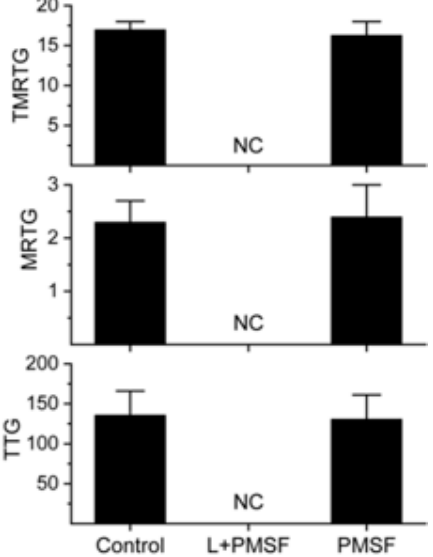
Figure 5. The effects of exposure of the LAAO to phenylmethylsulfonyl fluoride (PMSF). The data are displayed as the mean ± SD. TMRTG = minutes; MRTG = dynes/cm 2 /sec; TTG = dynes/cm 2 . Control = Control plasma without LAAO addition; L + PMSF = LAAO exposed to 1 mM PMSF; PMSF = plasma exposed to 10 µM PMSF; NC = no measurable coagulation.